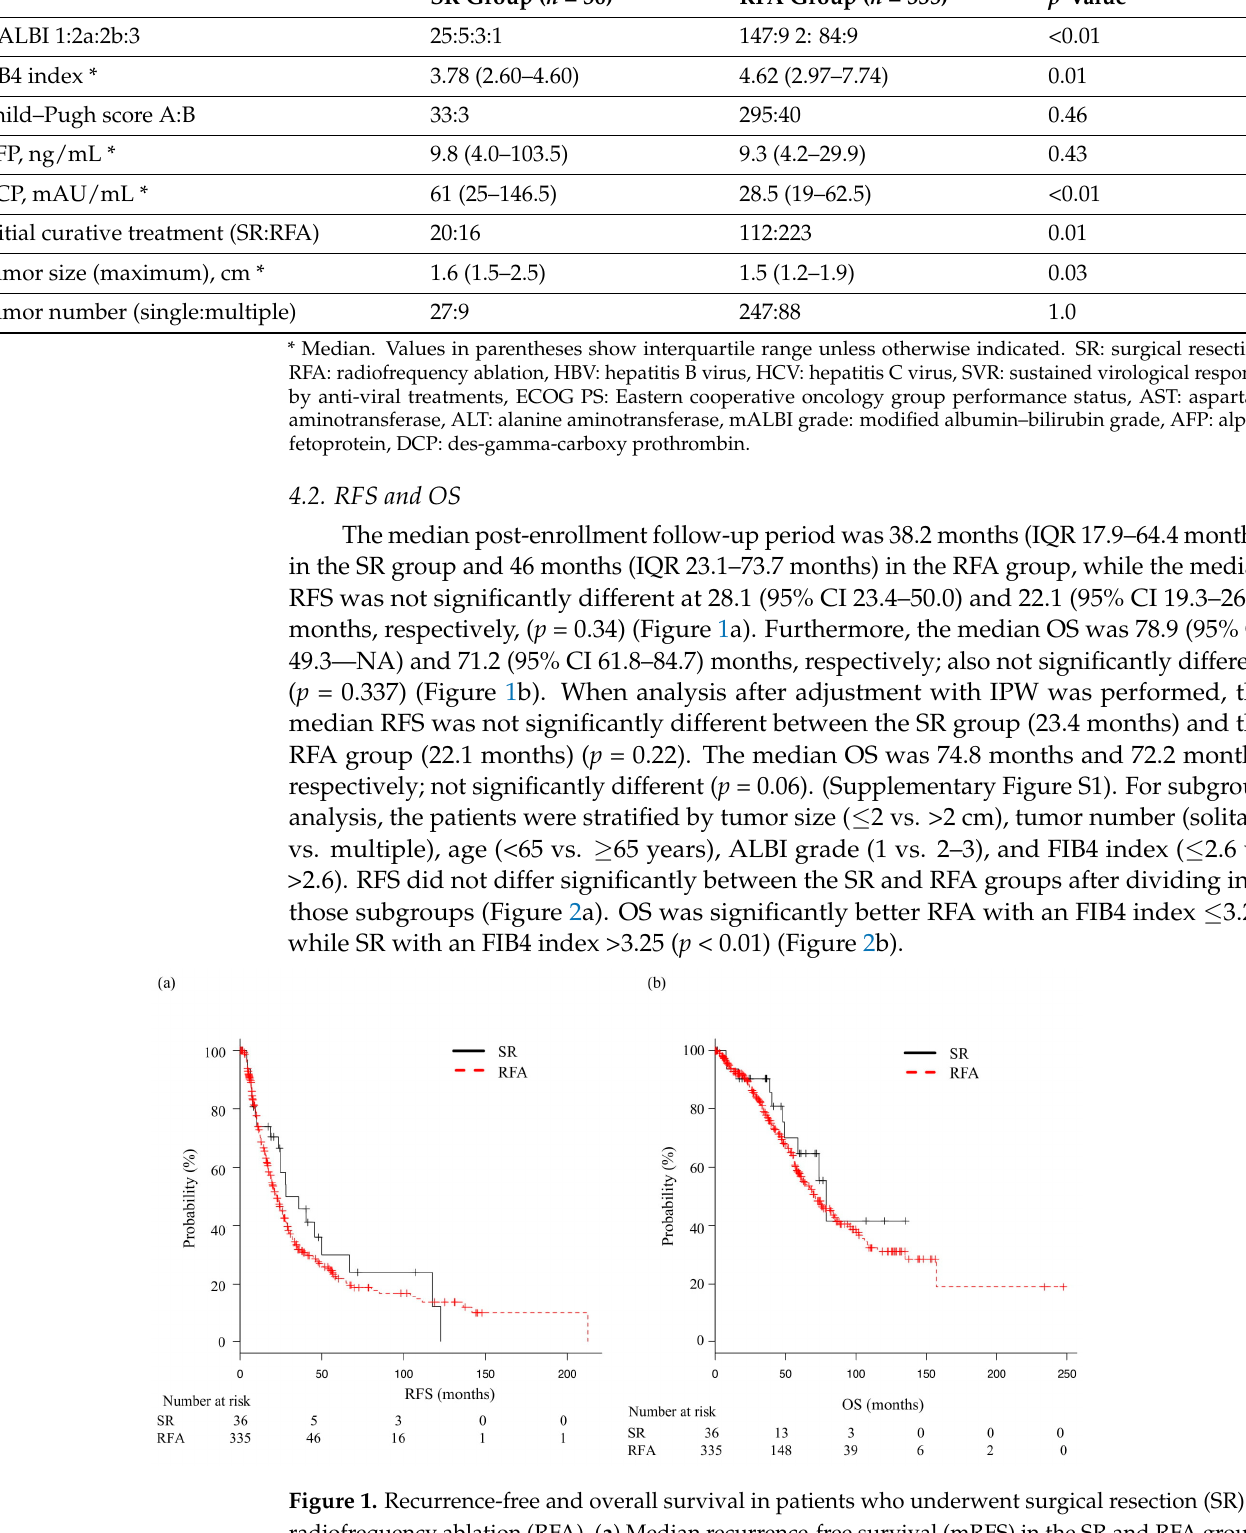
Figure 2. Subgroup analysis of recurrence-free survival (RFS) and overall survival (OS) in surgical resection (SR) and radiofrequency ablation (RFA) groups. ( a ) RFS did not differ significantly be- tween the SR and RFA groups after dividing into subgroups. ( b ) OS was significantly better RFA with FIB4 index ≤ 3.25, while SR with FIB4 index > 3.25 ( p < 0.01). 4.3. Adverse Events There was no significant difference in the rate of incidence of adverse events between the SR and RFA groups (8.3% vs. 9.3%, p = 1.0). In the SR group, adverse events developed in three patients, including bile leakage ( n = 1, 2.8%), duodenal ulcer bleeding ( n = 1, 2.8%), and abscess at the resection margin ( n = 1, 2.8%), while adverse events were noted in 31 in the RFA group, with the most common including liver infarction ( n = 6, 1.8%),